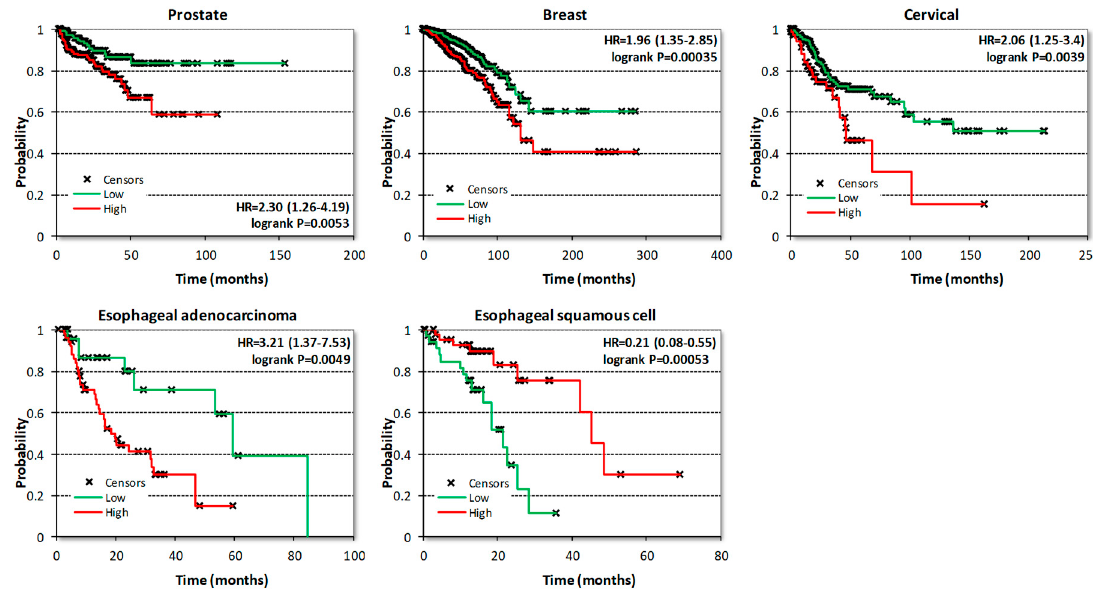
Figure 6. Examples of Kaplan-Meier (KM) plots correlating CDK8 expression with time to overall survival (OS) or to biochemical relapse (BCR) in the case of prostate cancer.